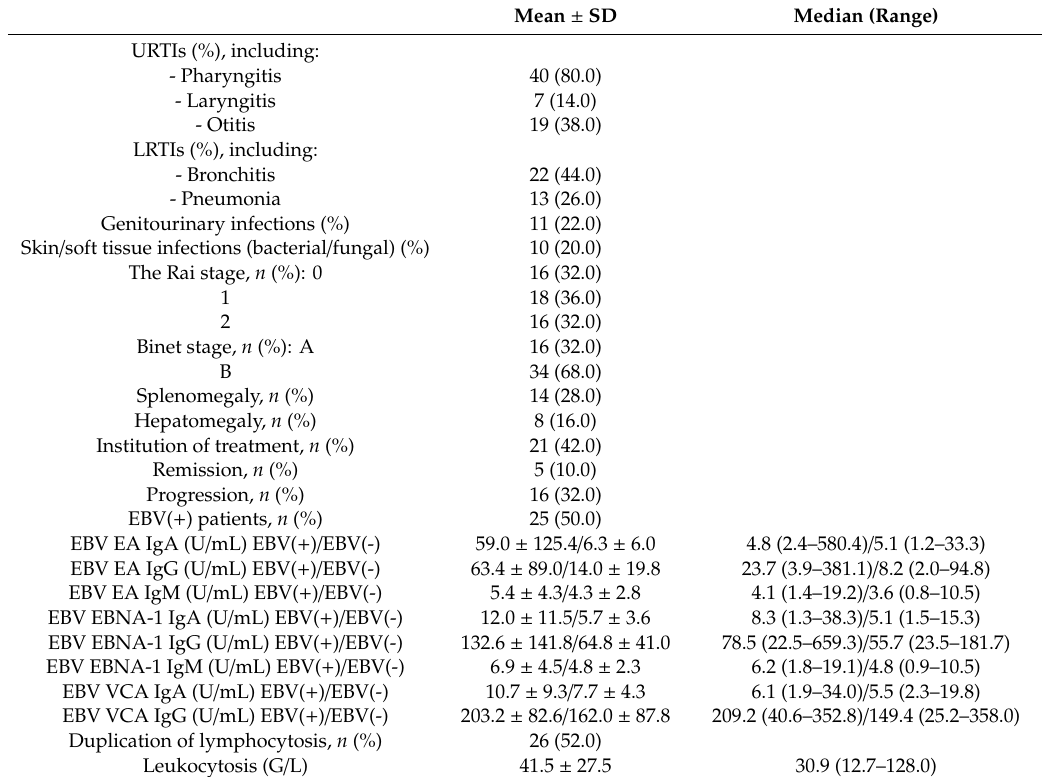
Table 2. Clinical and laboratory parameters of the CLL